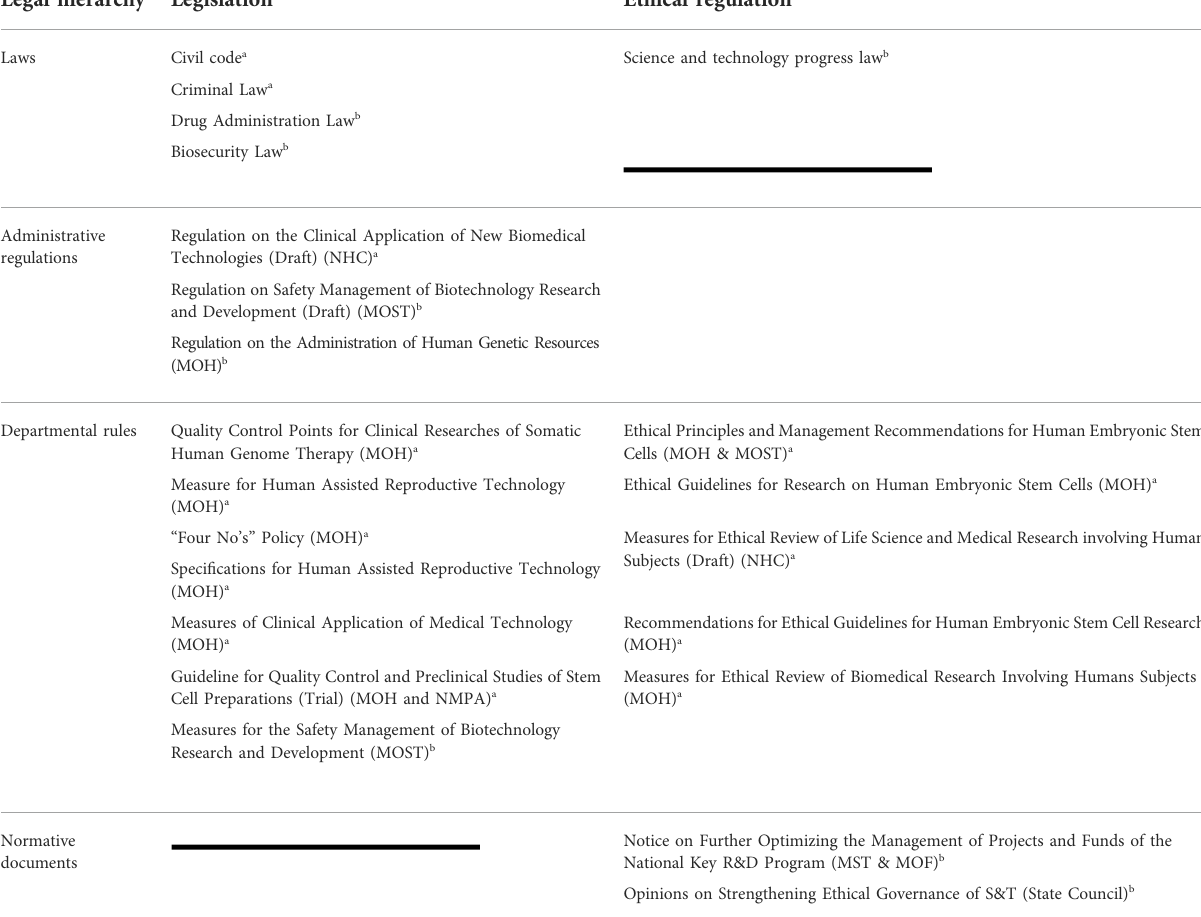
TABLE 2 China ’ s legal framework involving the human embryo and embryoid